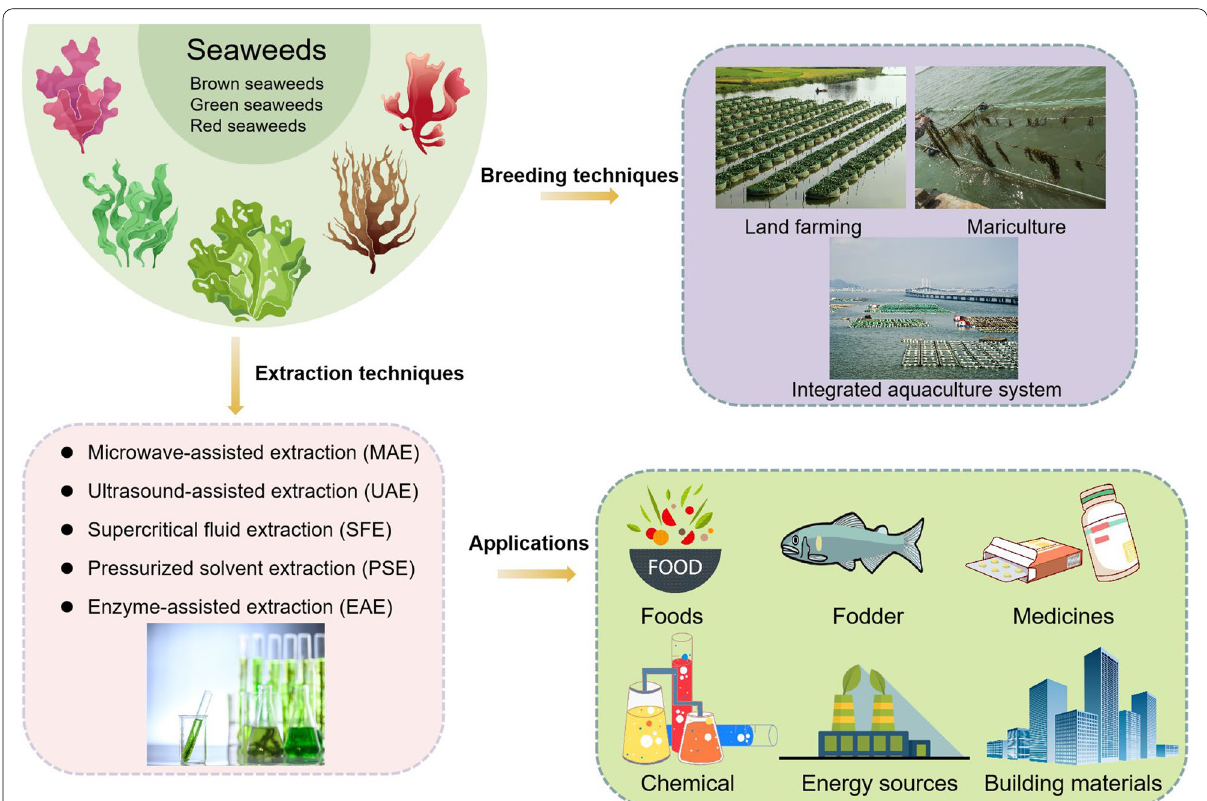
Fig. 4 Overview of the global state of farming, extraction, and applications of